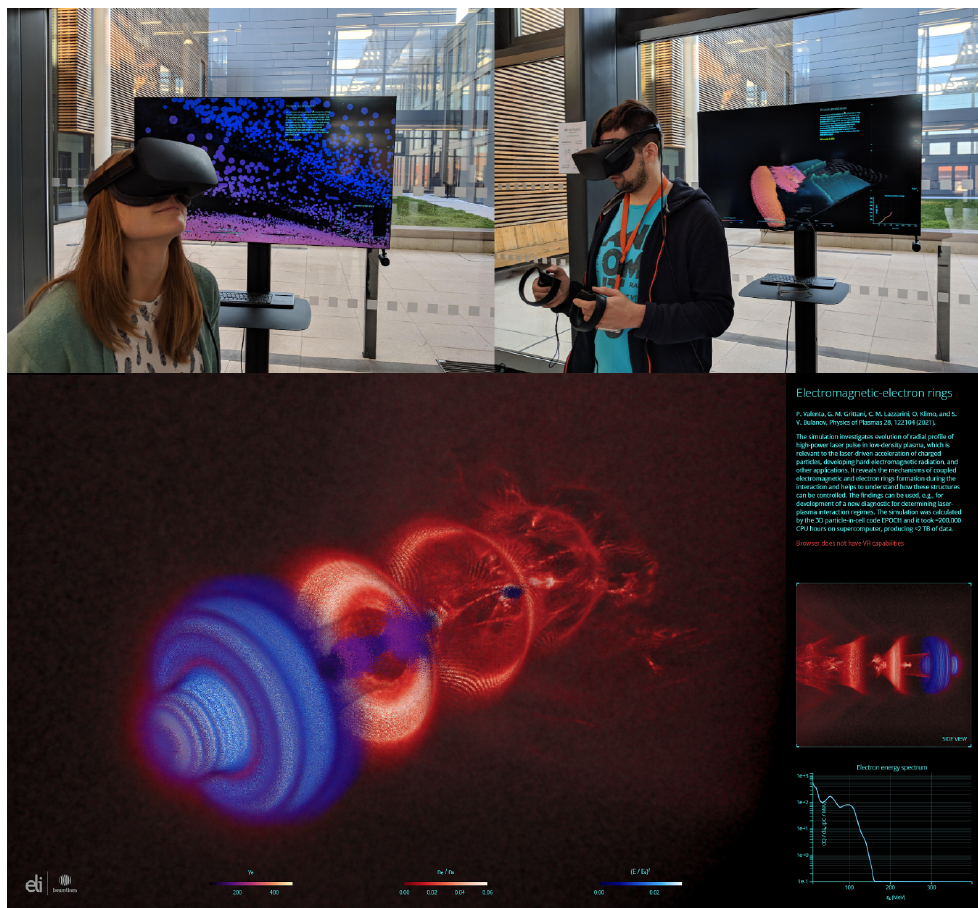
Figure A1. VBL application. ( top ) The use of the VBL application on the VR stations at ELI Beamlines (photo from [83]). ( bottom ) Example of a visualization based on the 3D PIC simulation data [116] using the VBL